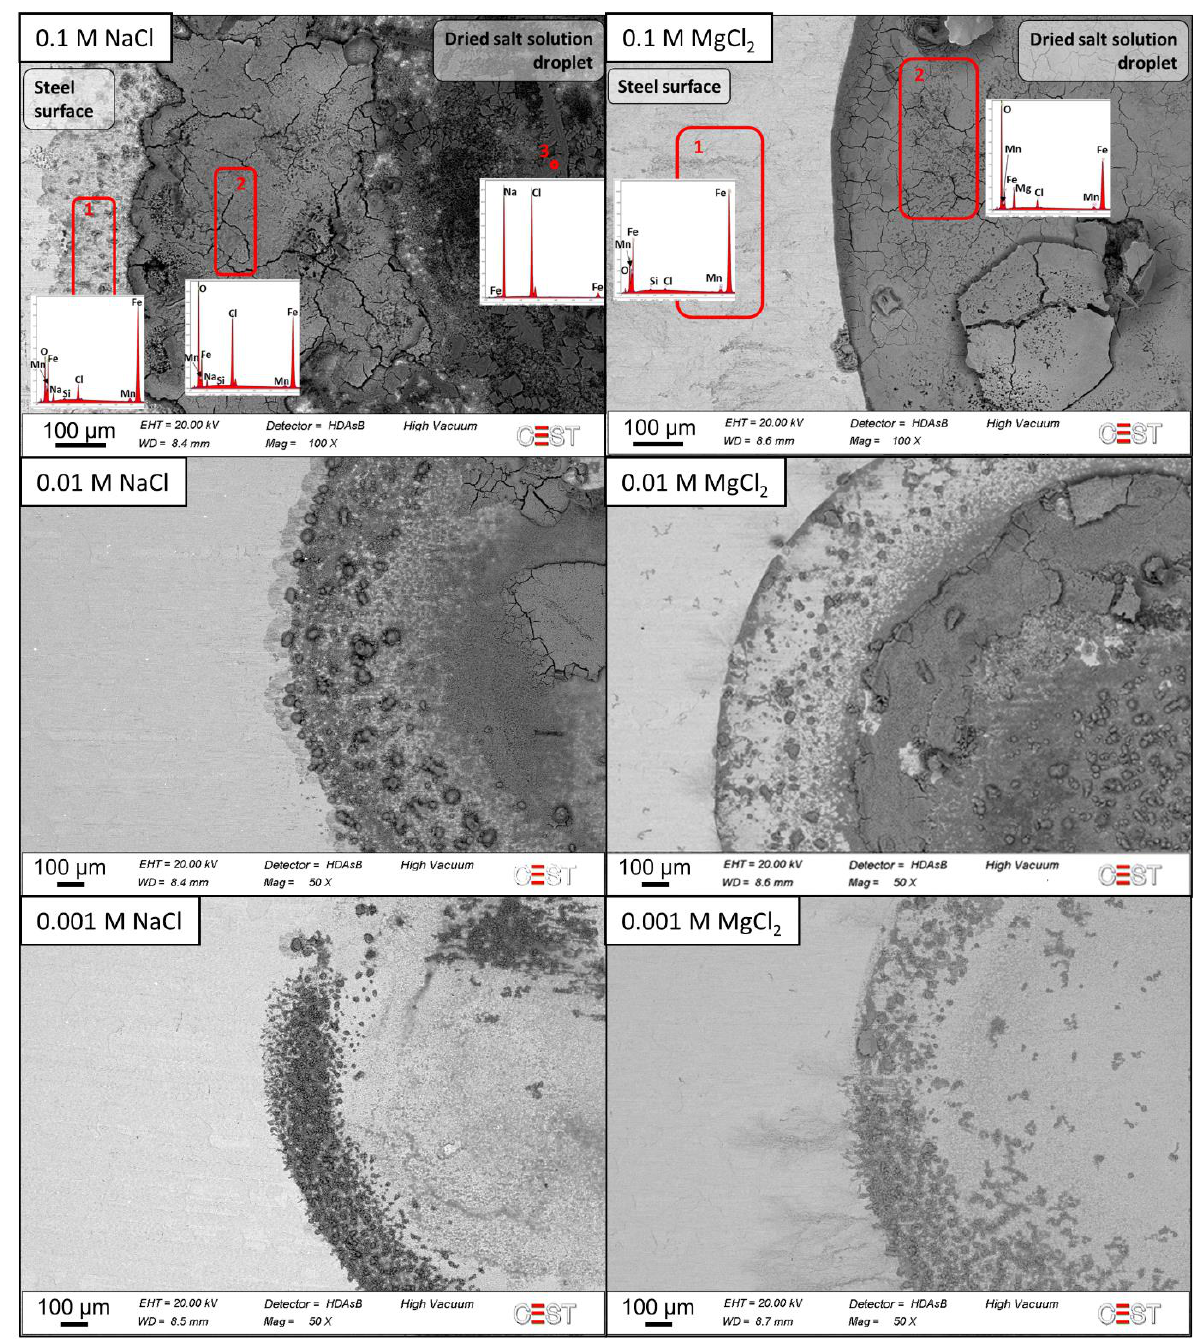
Figure 6. SEM images and EDX results from CP1000 surface and dried droplets of NaCl and MgCl 2 aqueous